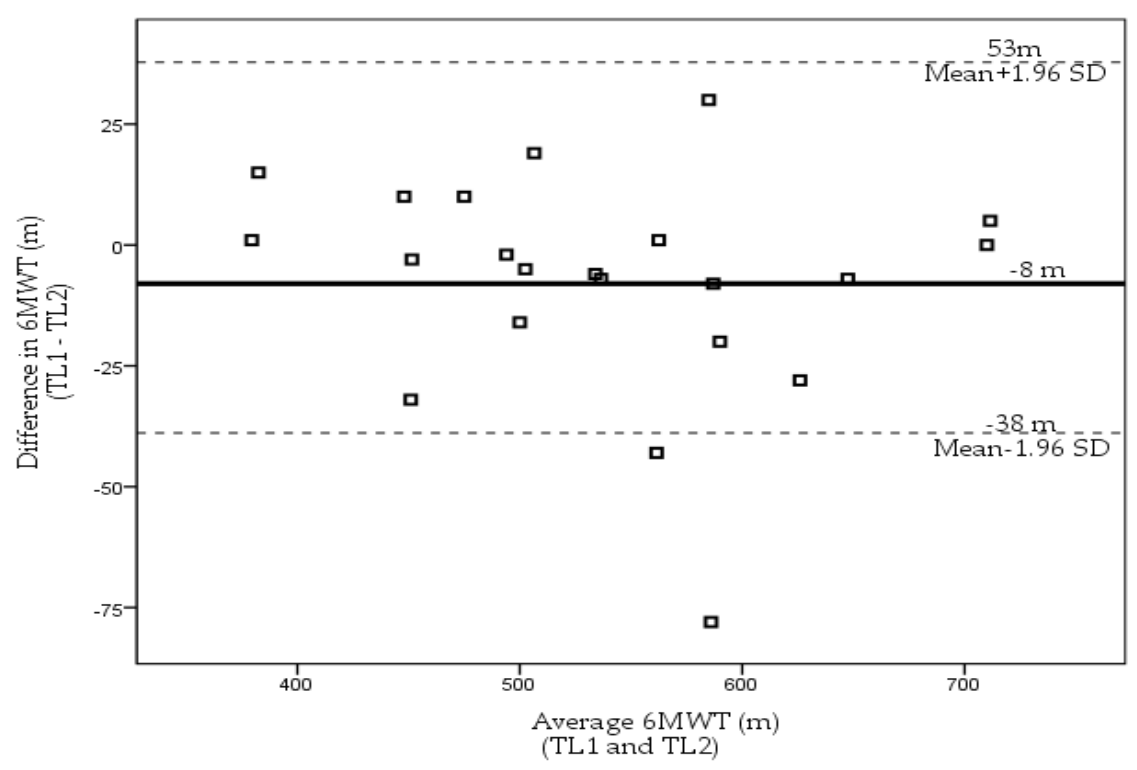
Figure 2. Limits of agreement plot (Bland–Altman Plot). Intra-individual differences between performances on the 6MWT on the two TL 6MWTs (from TL1 to TL2) plotted against intra-individual average distance scores of the TL1 and TL2. The central line represents the mean of the intra-individual differences, and the flanking lines represent the 95% limits of agreement. Mean difference is − 8 m. Table 2. Evaluation of the differences of the CB and TL 6MWT assessment.